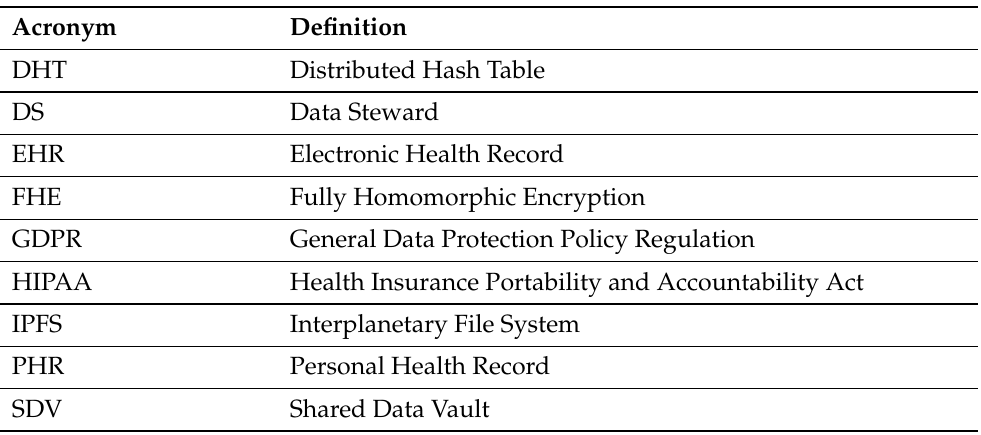
Figure 1. Solution contribution: In the traditional model for PHR management, the health institution is responsible for managing PHR data, and it is usually stored in unencrypted and paper formats. The proposed model provides control over PHR to individuals and promotes end-to-end encryption to protect privacy. Table 1. Table of